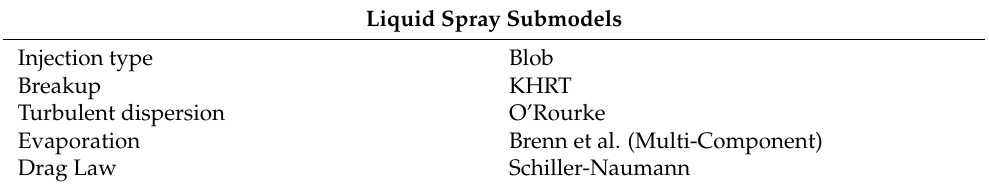
Table 8. Summary of Lagrangian numerical